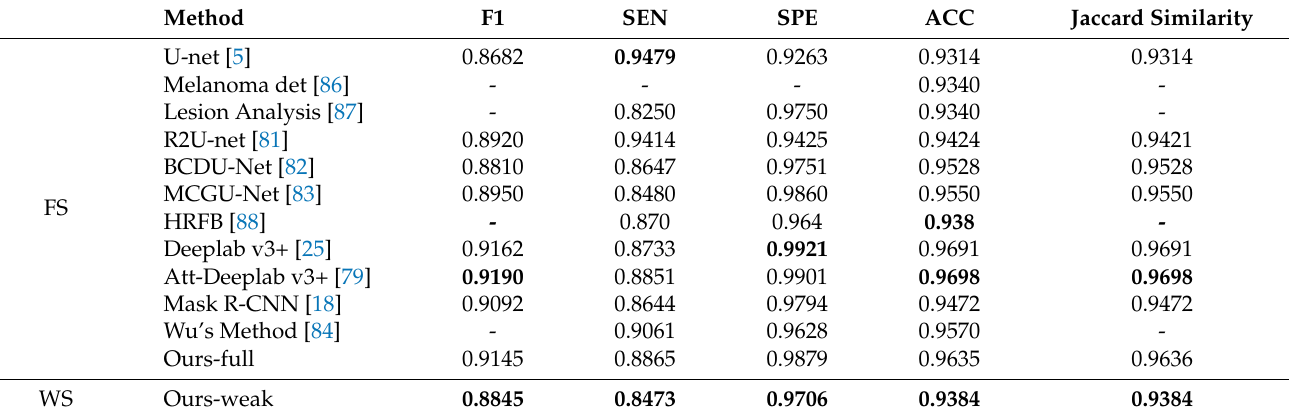
Table 3. Performance comparison of the proposed segmentation network and other methods on ISIC 2017 dataset.